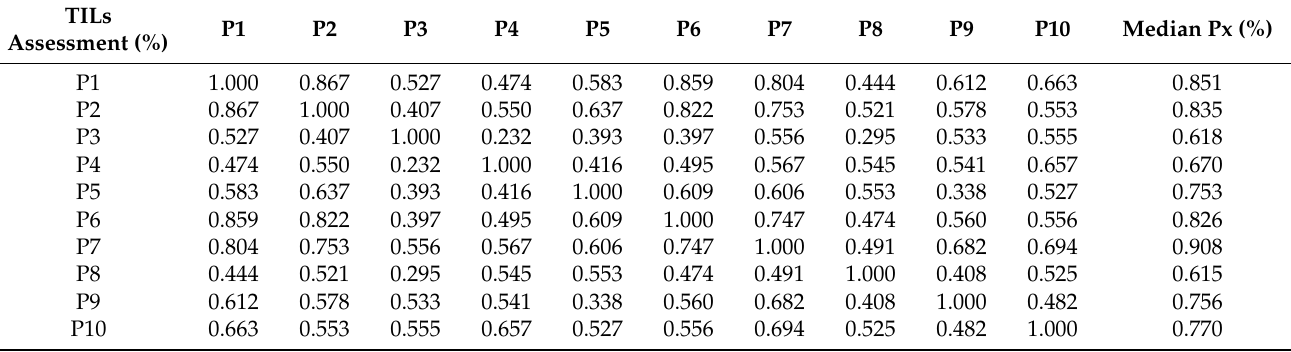
Table 4. Intraclass correlation coefficients for TILs assessment as percentages in the study set, as evaluated by ten partici- pating pathologists. Because an ad hoc consensus score was lacking, the median Px TILs score was used as a surrogate consensus